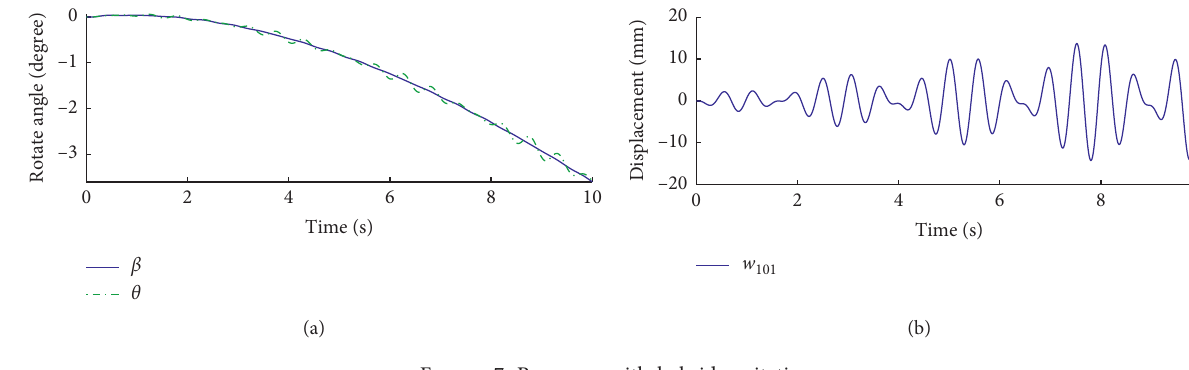
Figure 7: Response with hybrid